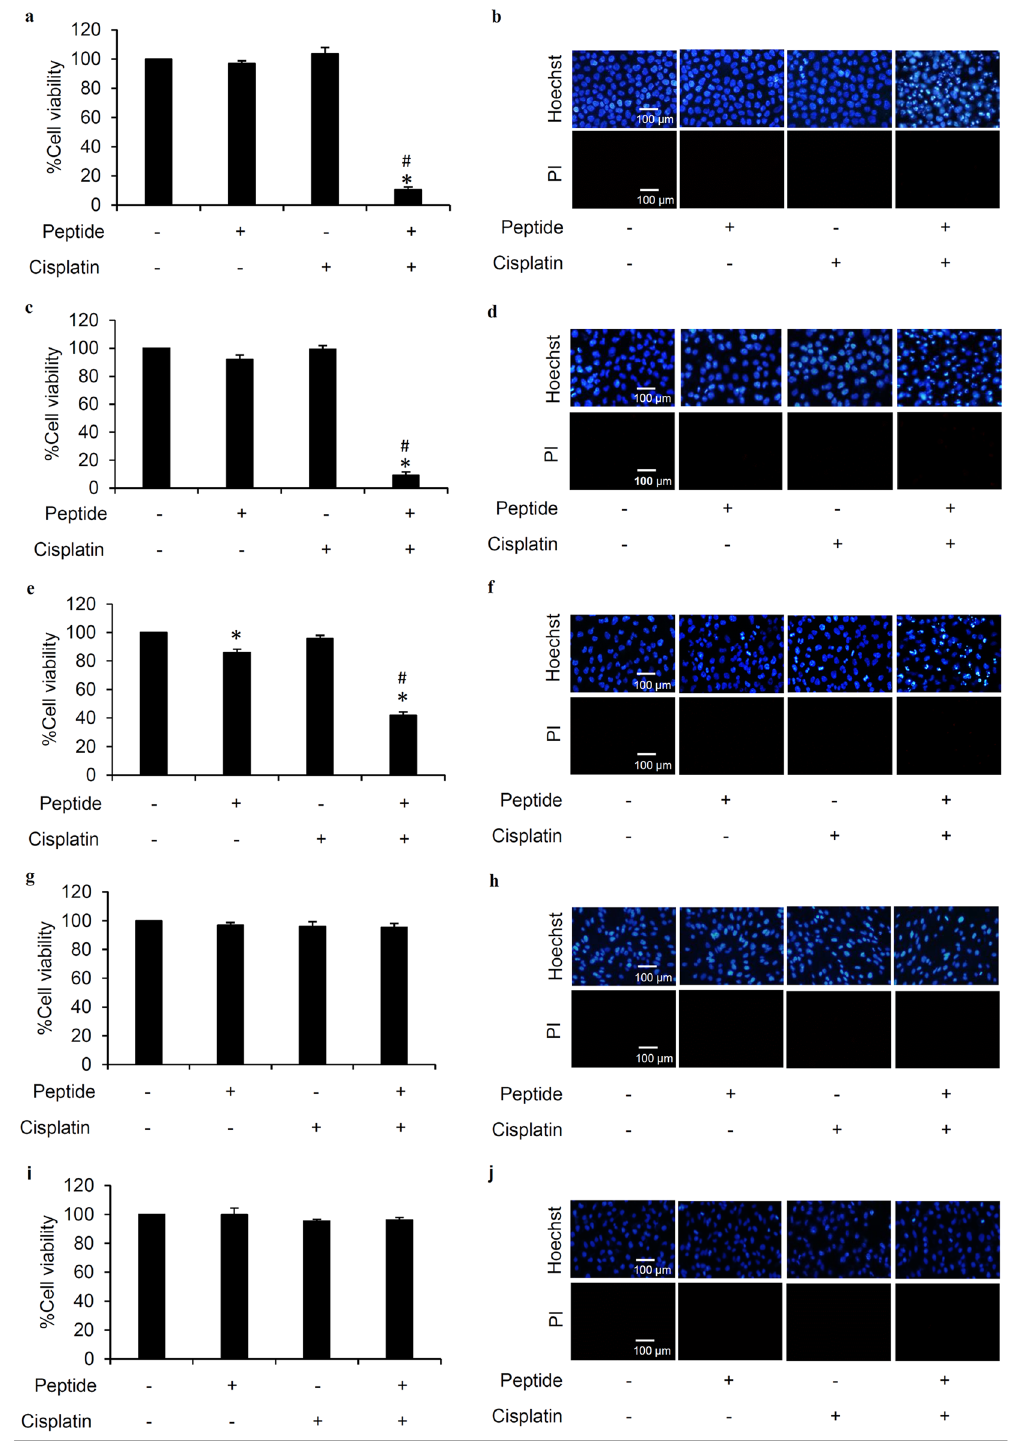
Figure 6. Peptide from Lentinus squarrosulus Mont. shows high safety prolife. Chemosensitizing effect of 0.4 M NaCl peptide from L. squarrosulus was presented in various human lung cancer cells including ( a ) H23, ( c ) H292 and ( e ) A549 cells. In comparison to cells with or without cisplatin treatment, peptide preincubation combined with cisplatin treatment augmented observed apoptosis cells which are characterized by condensed DNA/fragmented nuclei stained by bright blue fluorescence of Hoechst33342 in ( b ) H23, ( d ) H292 and ( f ) A549 cells. MTT assay revealed no alteration of cell viability in ( g ) human dermal papilla DPCs cells and ( i ) human proximal renal HK-2 cells after preculture with 5 µg/mL of 0.4 M NaCl peptide for 24 h following with treatment with 5 µM cisplatin for another 24 h. No detectable apoptosis and necrosis were noted via costaining with Hoechst33342/propidium iodide (PI) in all treatments of ( h ) DPCs and ( j ) HK-2 cells. Values are means of three independent experiments ± SD. * p < 0.05 versus non-treated control cells, # p < 0.05 versus the cells treated only with